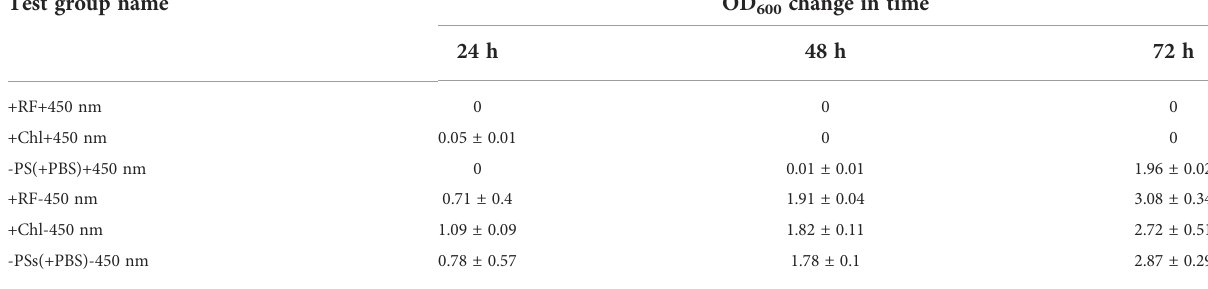
TABLE 4 Ability of the bio fi lm-forming Brevundimonas sp. ESA1 cells to regrow in LB media after long-term RF-API and Chl-API (+RF+450 nm and +Chl+450 nm, respectively) using CIP, irradiation without PSs (-PSs(+PBS)+450 nm).